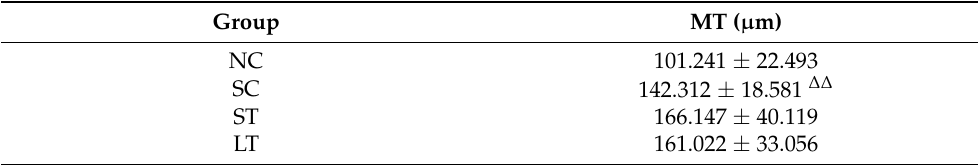
Figure 3. The aortic arch. NC group ( A ), SC group ( B ), ST group ( C ), and LT group ( D ). Table 2. The media thickness of the aortic arch after